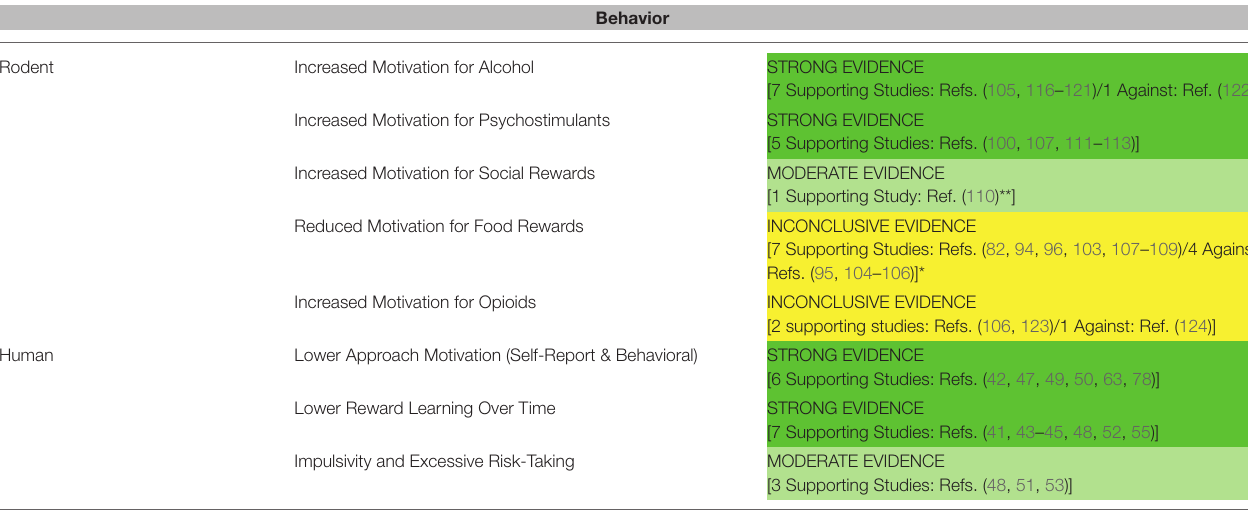
TABLE 1 | Significance of evidence for the effects of ELS on motivated behaviors in human and rodent model studies.